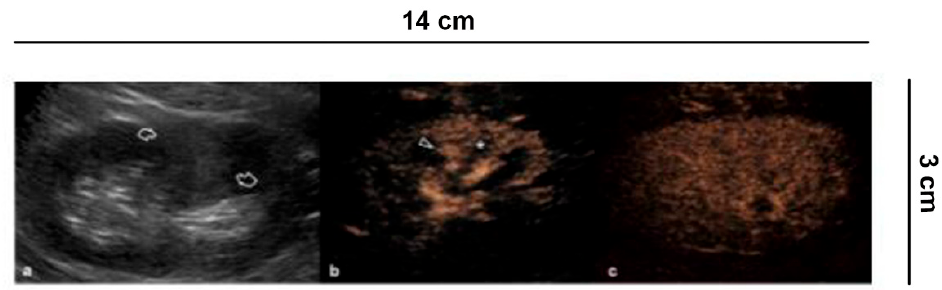
Figure 4. Differential diagnosis between solid renal masses and pseudo-tumors. ( a ) B-mode US shows a hyperechoic delimited area in the middle third of the left kidney as a possible solid lesion (curved arrows). ( b ) CEUS demonstrates, on the other hand, a normal cortical vascularization (arrowhead) with the intact medulla (asterisk) and with (c) the parenchymal phase preserved.